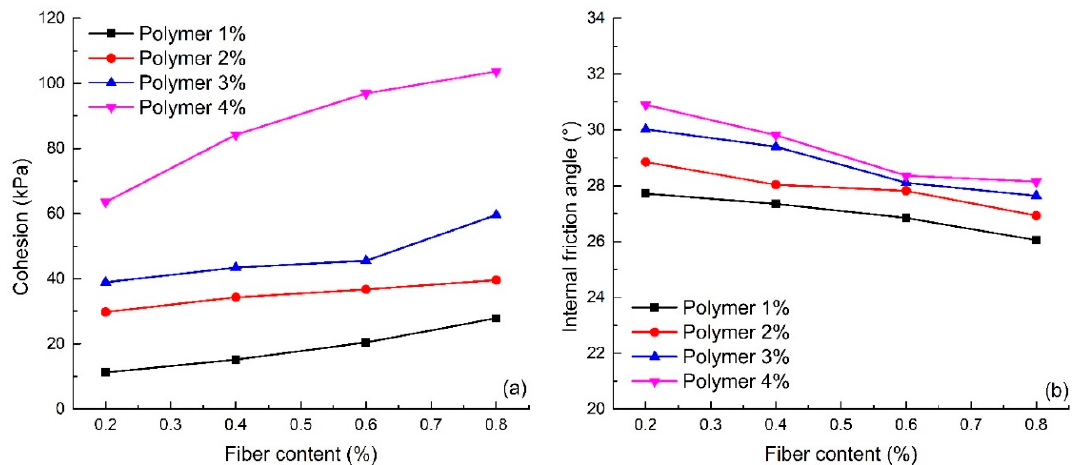
Figure 10. The variation curve of the shear strength parameters with the change of fiber content: ( a ) Cohesion; ( b ) Internal friction angle.